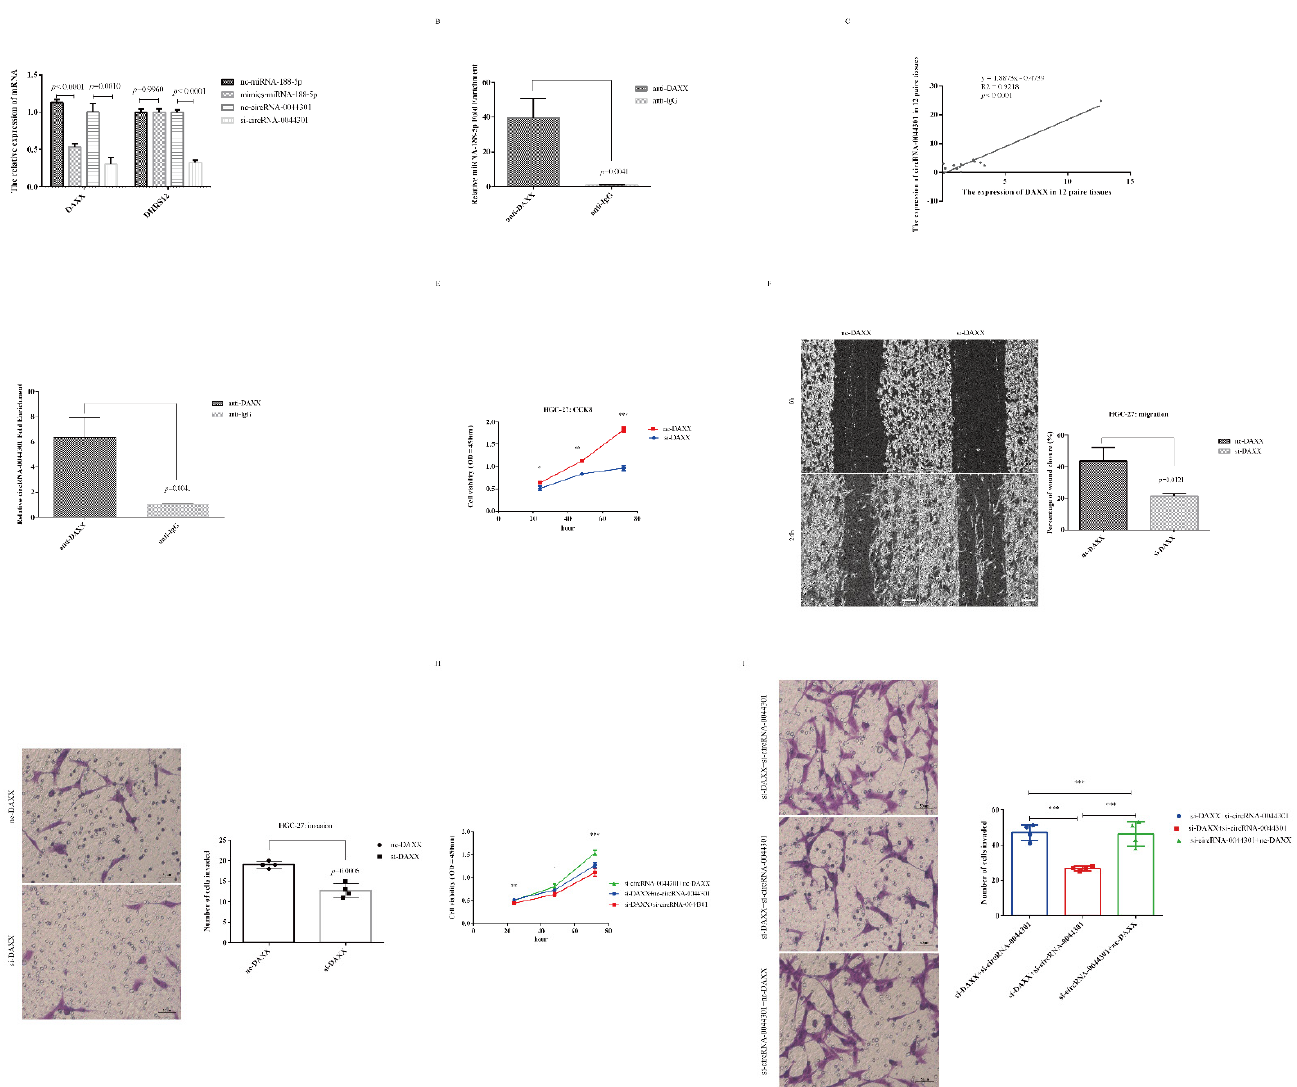
Figure 7. The function of DAXX and the association between DAXX and circRNA-0044301 . ( A ) qRT-PCR analysis of DAXX and DHRS12 expression in mimics-miRNA-188-5p or nc-miRNA-188-5p and si-circRNA-0044301 or nc-circRNA-0044301 transfected cells. ( B ) RIP-qRT-PCR experiments confirmed the interaction between miRNA-188-5p and DAXX. (C) Correlation analysis of DAXX expression level and circRNA-0044301 expression level; their expression was positively correlated ( p < 0.0001). ( D ) RIP-qRT-PCR experiments confirmed the interaction between circRNA-0044301 and DAXX. ( E ) CCK-8 assay of the cell viability of HGC-27 cells with si-DAXX or nc-DAXX transfection (***: p < 0.001; **: p < 0.01; *: p < 0.05). ( F ) Wound healing assay for the cell migration ability of GC cells after knockdown of DAXX over time (0 h and 24 h), and the percentage of wound closure was statistically analyzed (the samples were imaged at 50× magnification. Scale bar = 200 µm). ( G ) Results of Transwell assays with si-DAXX and nc-DAXX transfection into HGC-27 cells (the samples were imaged at 200x magnification. Scale bar = 50 µm). ( H ) CCK-8 assay for the cell viability of GC cells after si-DAXX, si-circRNA-0044301, and co-transfection into HGC-27 cells; the viability of the GC cell lines in the co-transfection group was significantly lower than that in the single transfection group (***: p < 0.001; **: p < 0.01; *: p < 0.05). ( I ) Transwell assay for the cell invasion ability of GC cells after si-DAXX, si-circRNA-0044301, or co-transfection into HGC-27 cells; the invasion ability of the GC cell lines in the co-transfection group was significantly lower than that in the single transfection group (the samples were imaged at 200x magnification. Scale bar = 50 µm. ***: p < 0.001).